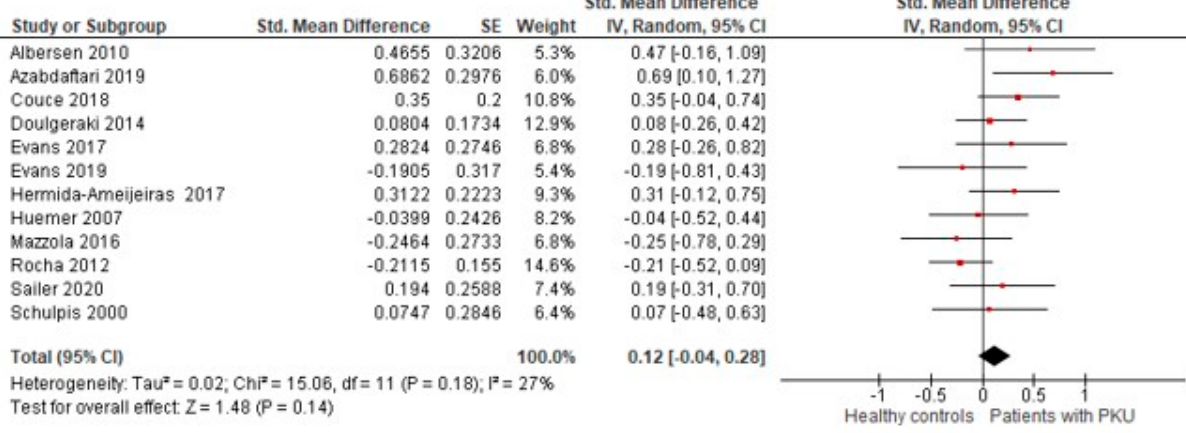
Figure 3. Forest plot comparing the BMI between patients with PKU and healthy controls. Abbreviations: BMI: body mass index; CI: confidence interval; df: degrees of freedom; IV: inverse variance; PKU: phenylketonuria; SE: standard error; Std: standardised. Moderate risk of bias: Couce 2018, Evans 2019, Huemer 2007, and Rocha 2012. High risk of bias: Albersen 2010, Azabdaftari 2019, Doulgeraki 2014, Evans 2017, Hermida-Ameijeiras 2017, Mazzola 2016, Sailer 2020, and Schulpis 2000. Time of diagnosis: Couce 2018 included 70 early and 13 late diagnosed patients, Hermida-Ameijeiras 2017 included both early and late diagnosed patients, Mazzola 2016 included 11 early and 16 late diagnosed patients, and Schulpis 2000 did not provide information on the time of diagnosis. Metabolic control: Azabdaftari 2019 included only one patient with good metabolic control (Phe blood levels < 600 μ mol/L). BH4 treatment: Couce 2018 included 10 (12%) patients taking BH4, Evans 2017 included 5 (14%), Hermida-Ameijeiras 2017 included 7 (17%), and Sailer 2020 included 4 (13%).